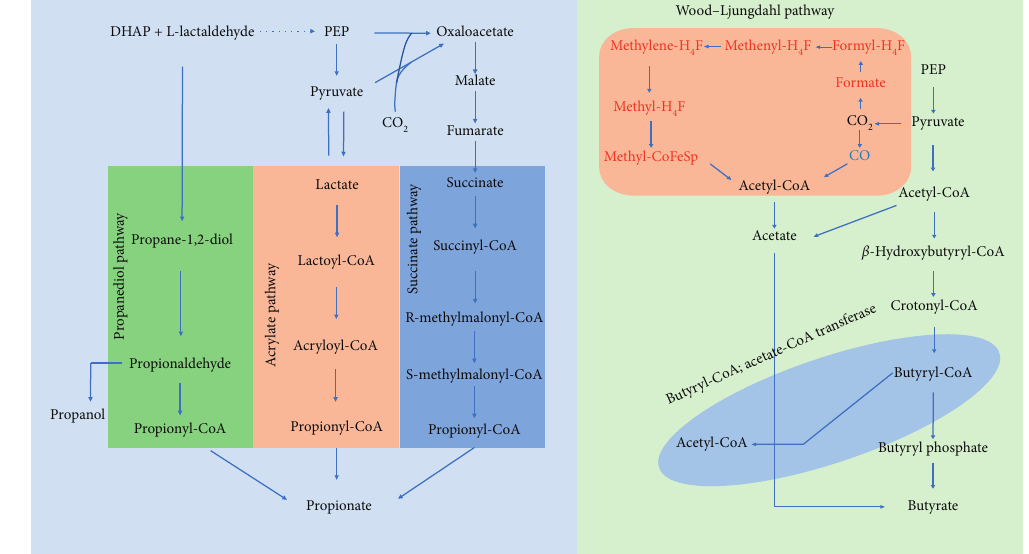
Figure 1: Pathways for biosynthesis of propionic acid, acetic acid, and butyric acid in